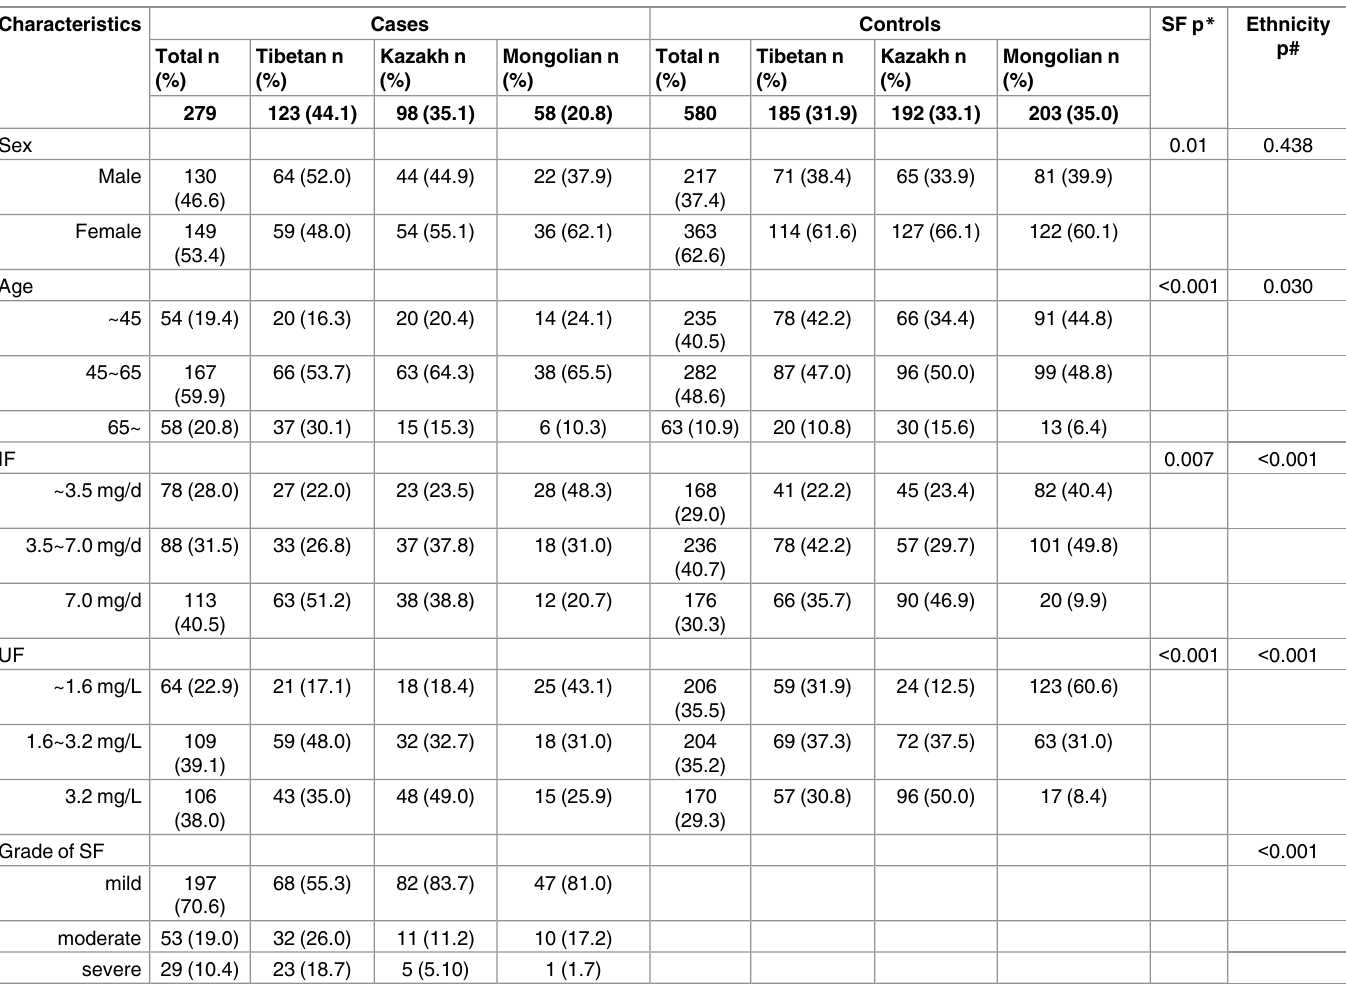
Table 1. General characteristics of study populations. Characteristics